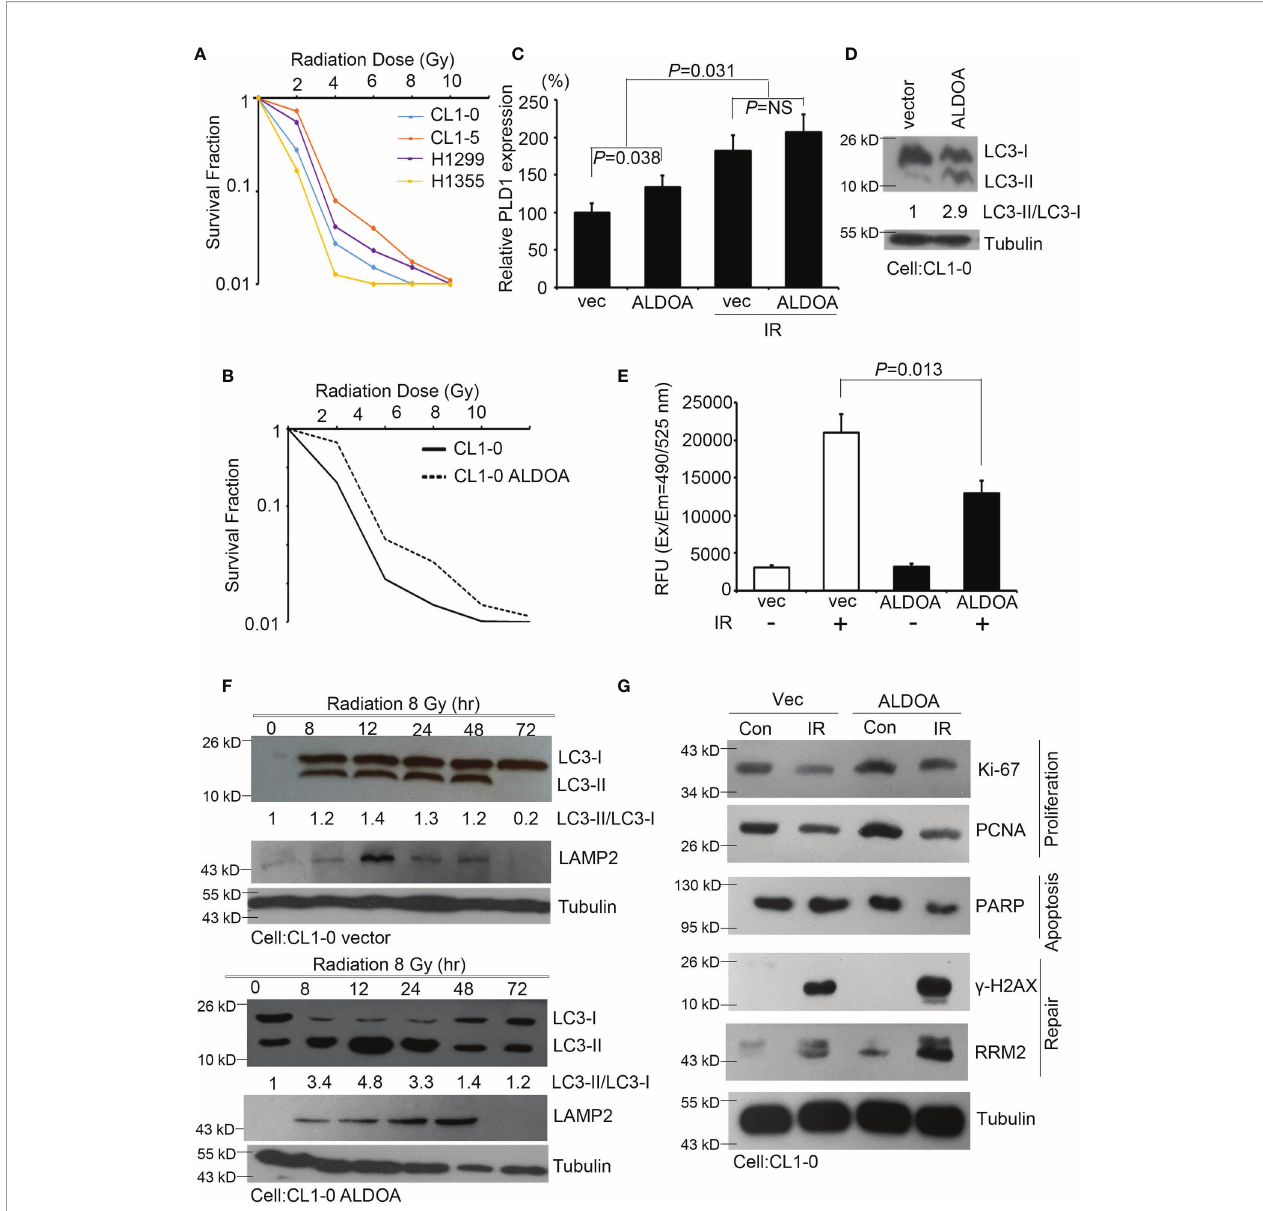
FIGURE 5 | ALDOA increases autophagy and invasion sensitivity after radiation exposure. (A) The survival fraction after radiation exposure in various lung cancer cells (CL1- 0, CL1-5, H1299, and H1355). Radiation dose: 0~10 Gy. (B) The survival fraction after radiation exposure in CL1-0 cells with vector control or ALDOA overexpression. Radiation dose: 0~10 Gy. (C) Quantify the expression levels of PLD1 after radiation exposure in CL1-0 cells with vector control or ALDOA overexpression. Radiation dose: 8 Gy (D) The LC3-I/II protein level in CL1-0 cells with vector control or ALDOA overexpression. Tubulin serves as an internal control. Radiation dose: 8 Gy (E) Quantitation of the activity of caspase-3 in A549 cells after alkylating agent exposure in CL1-0 cells with vector control or ALDOA overexpression. Radiation dose: 8 Gy (F) The LC3-I/II and LAMP2 protein level after radiation exposure in a time-dependent manner in CL1-0 cells with vector control or ALDOA overexpression. Tubulin serves as an internal control. Radiation dose: 8 Gy. (G) The Ki-67, PCNA, PARP, g -H2AX, and RRM2 protein level after radiation exposure in CL1-0 cells with vector control or ALDOA overexpression. Tubulin serves as an internal control. Radiation dose: 8 Gy. The data from three independent experiments are presented in (B – D) as the means ± SEM. The signi fi cance of the difference was analyzed using the nonparametric Mann – Whitney U